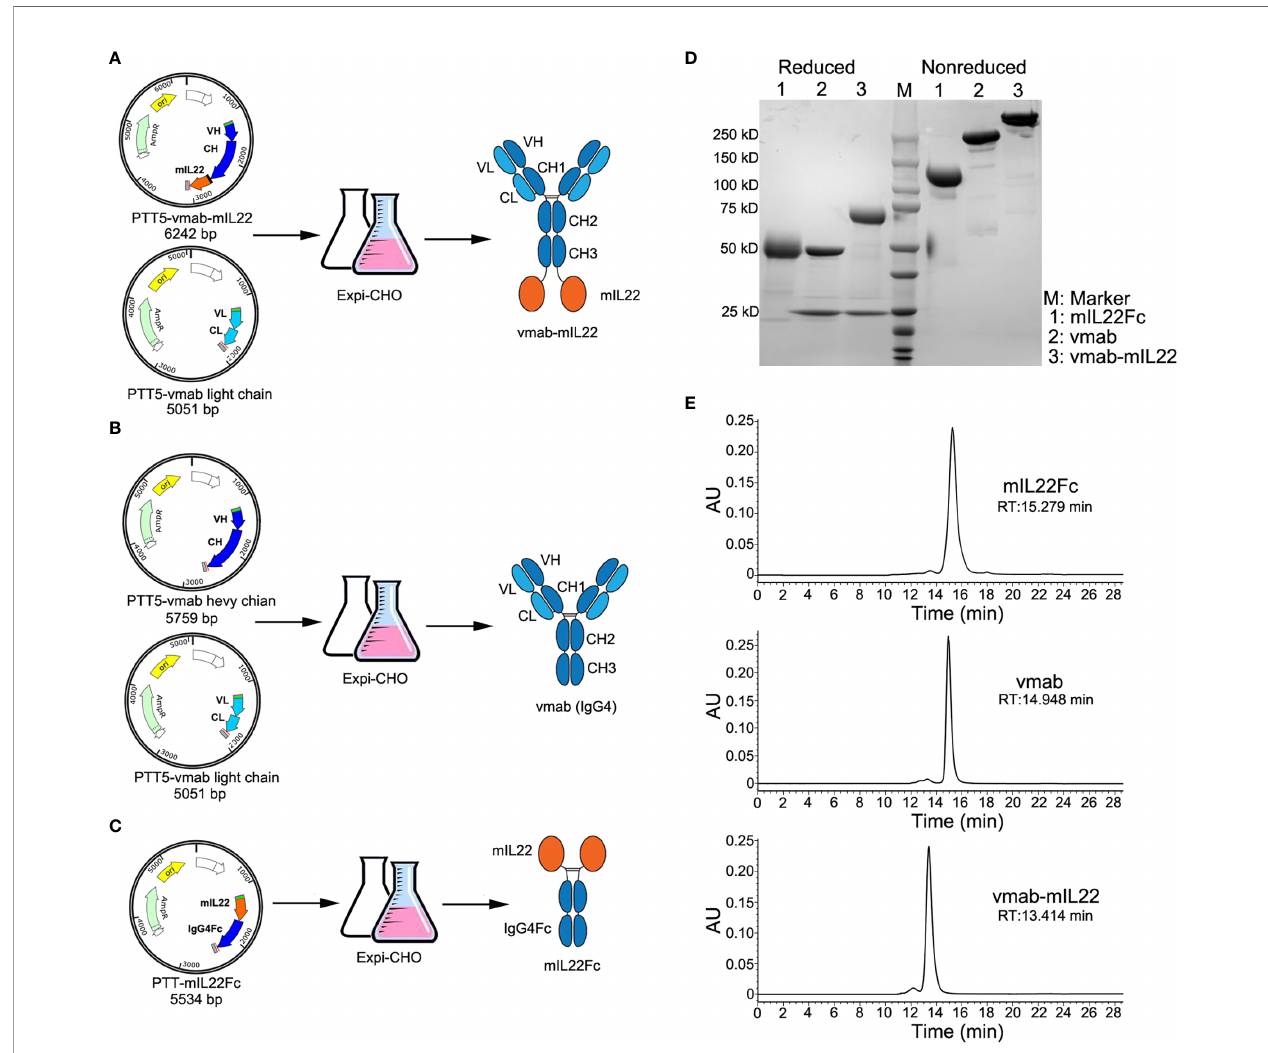
FIGURE 1 | Cloning, expression, and characterization of vmab-mIL22, vmab and mIL22Fc. (A) Schematic representation of the cloning strategy and expression data for vmab-mIL22. Mouse IL22 fused to the C-terminus of the heavy chain of vunakizumab (vmab) via a 15-amino acid (aa) linker. (B) Schematic representation of the cloning strategy and expression data for vmab. (C) Schematic representation of the cloning strategy and expression data for mIL22Fc (mouse IL22 and IgG4 Fc fusion protein). (D) SDS-PAGE analysis of mIL22Fc (lane 1), vmab (lane 2) and vmab-mIL22 (lane 3) under either reducing or nonreducing conditions. (E) SEC-HPLC analysis of mIL22Fc, vmab and vmab-mIL22. VH: antibody variable heavy chain. VL: antibody variable light chain. CH: antibody heavy chain constant region. CL: antibody light chain constant region. mIL22: mouse IL-22. RT: retention